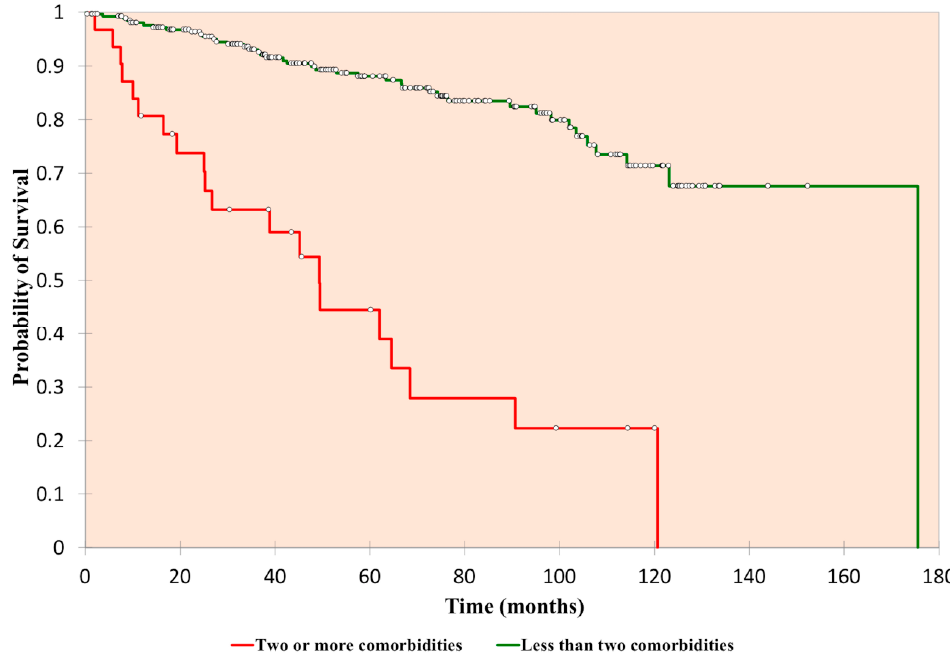
Figure 4. Kaplan-Meier analysis—overall survival of all complex cysts, two or more comorbidities versus less than two comorbidities.